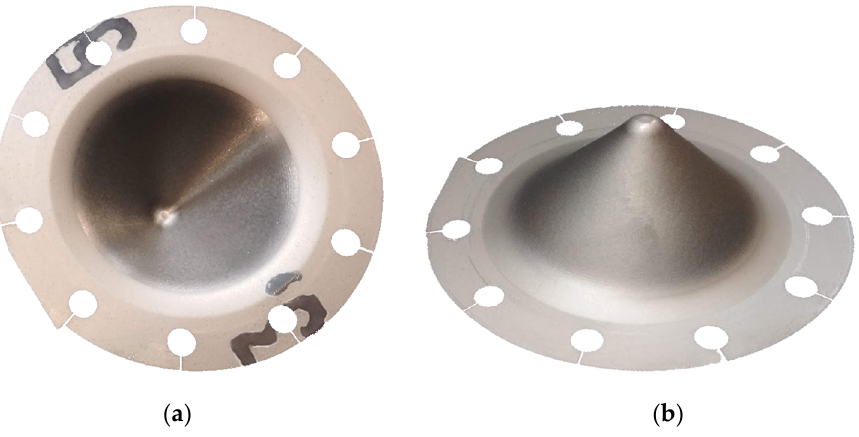
Figure 3 . Toolpaths strategies: ( a ) conventional and ( b ) climb